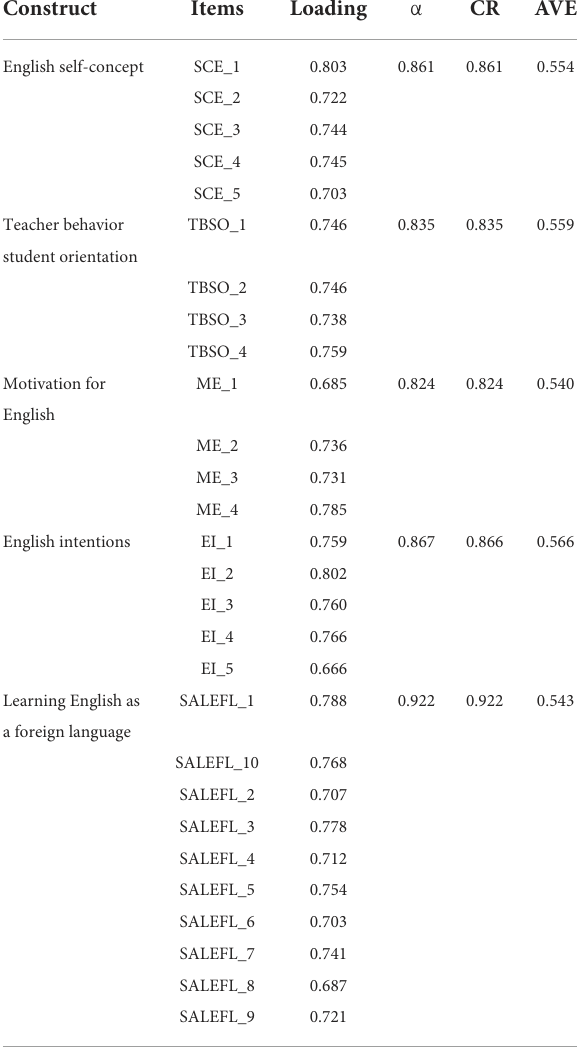
TABLE 2 Reliability and validity analysis.